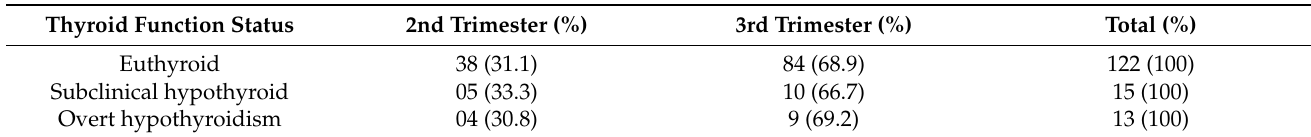
Table 7. Distribution of thyroid dysfunction according to gestational age among hypertensive pregnant